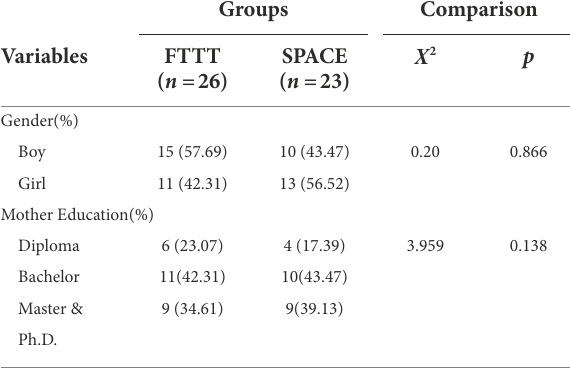
TABLE 4 The comparison of demographic data between intervention groups. Groups Comparison